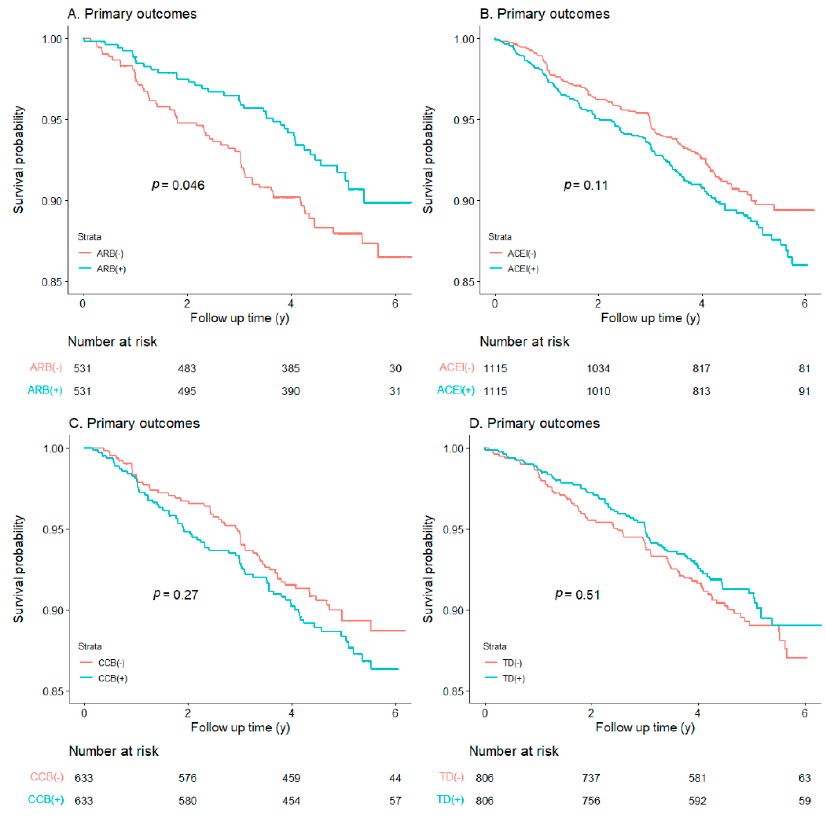
Figure 1. Kaplan − Meier survival analysis for primary outcomes within each antihypertensive therapy group. (( A ): ARB; ( B ): ACEI; ( C ): CCB; ( D ): TD). Table 2. Risks of primary outcomes for patients on different antihypertensive therapies compared to those